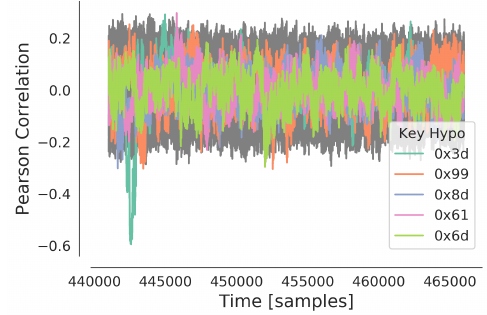
Figure 30: Pearson Correlation coefficients in Step 4 (byte 0) with 256